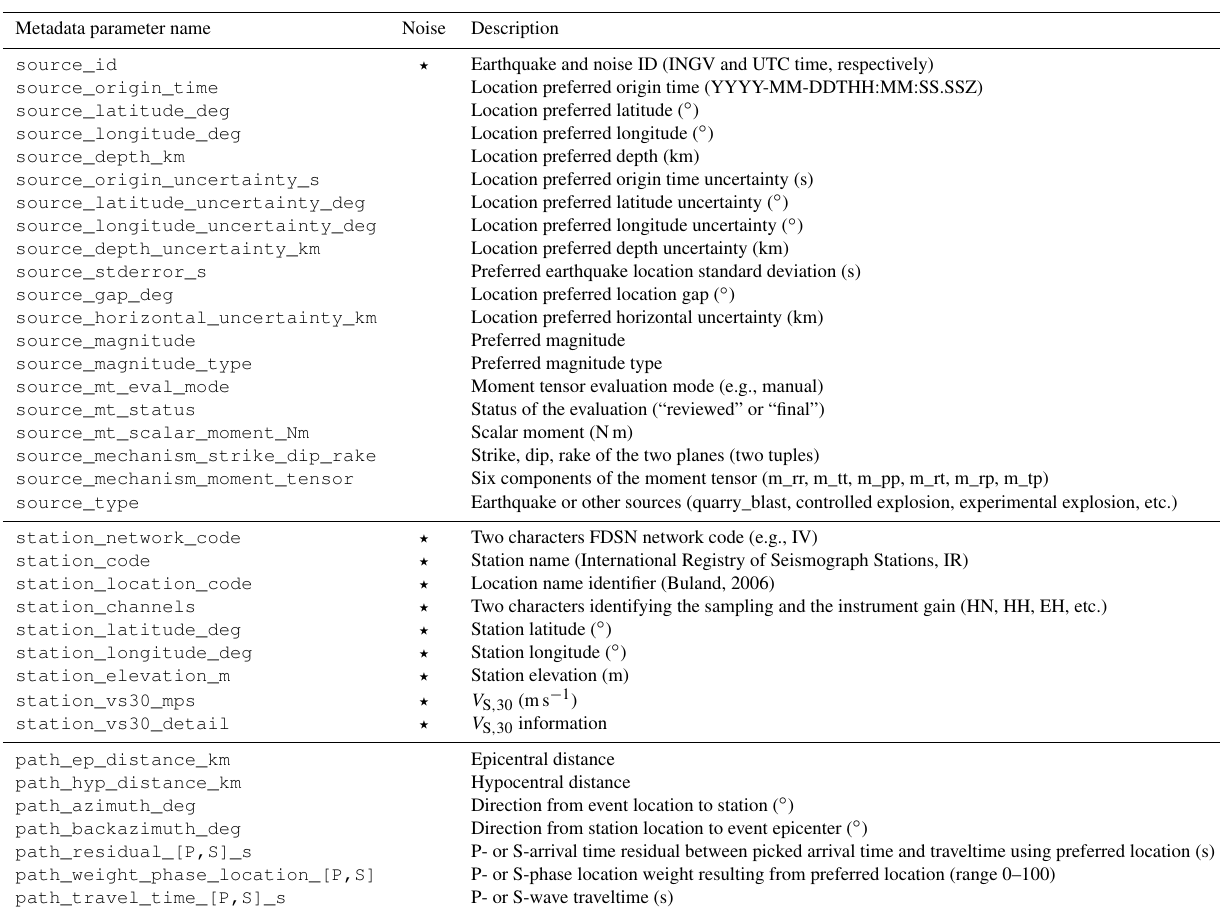
Table 2. List of the metadata for the events and noise waveform traces. The units are given in parenthesis in the “Description” column. Only a subset of metadata can be associated with the noise traces (star in the “Noise”